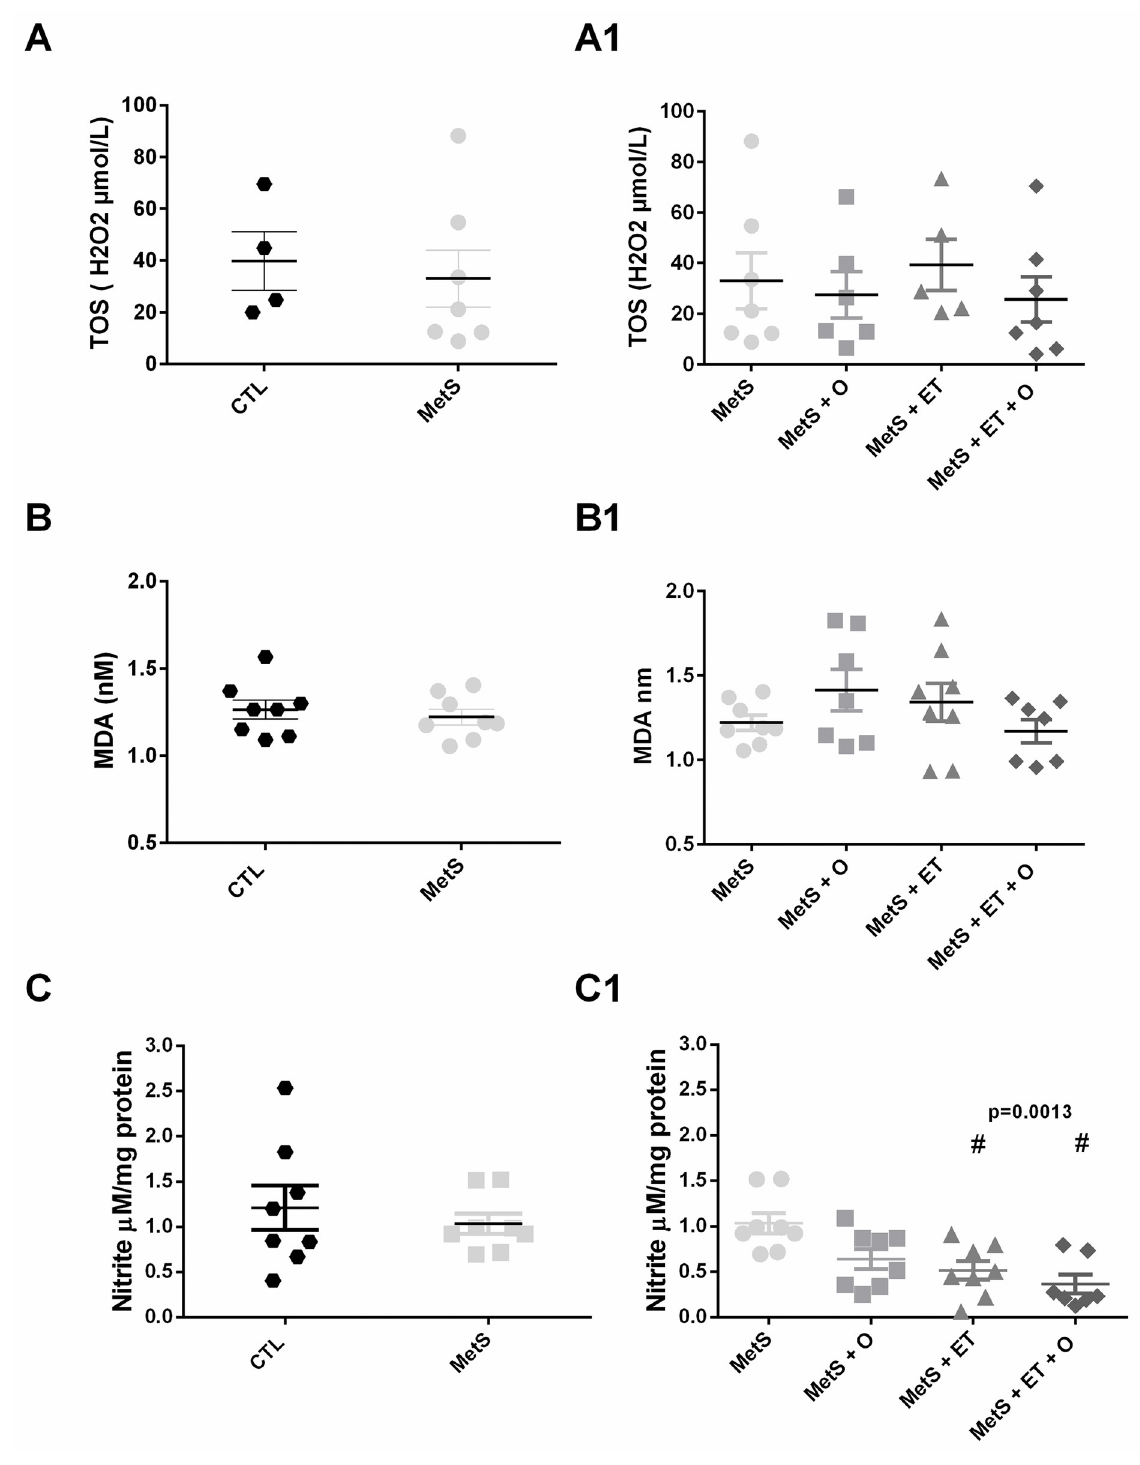
Fig 7. Analysis of oxidant enzymes. (A/A1) TOS, (B/B1) TBARS, (C/C1) Nitrite (p = 0.0013). #vs. MetS. Statistic: One-Way ANOVA, p < 0.05.